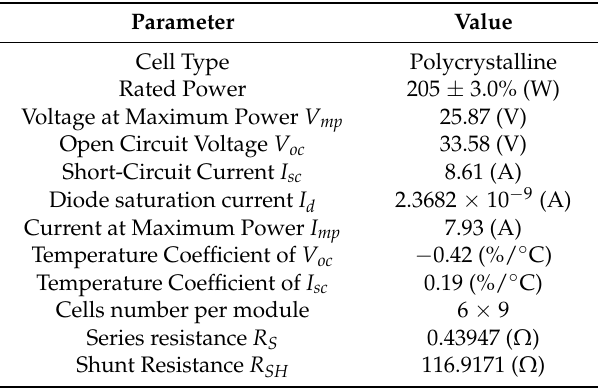
Table 2. Manufacturer Specifications for a PV